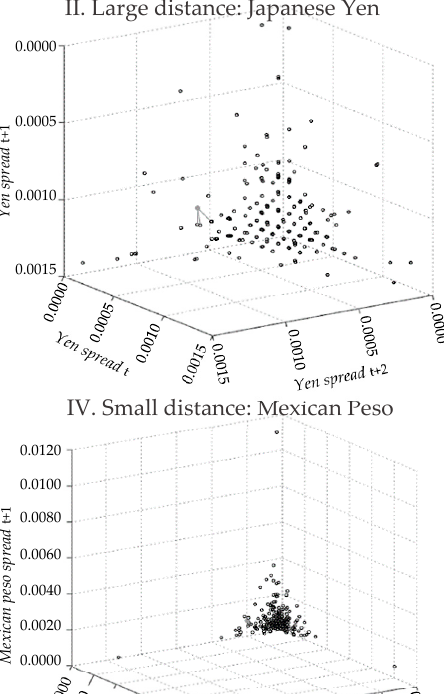
Table 6. Sum-of-squares residuals (SSR). Currency